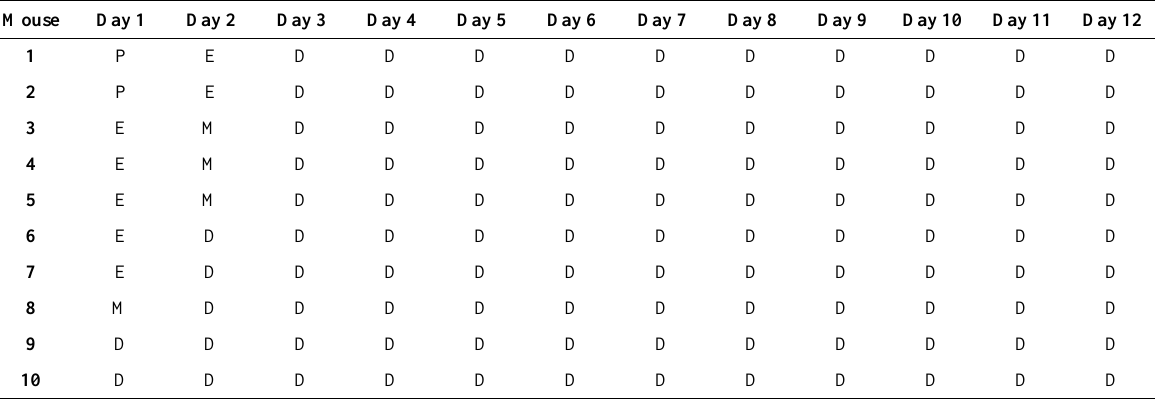
Table 1: Number of mice in each of the four phases of estrus cycle for 12 days of